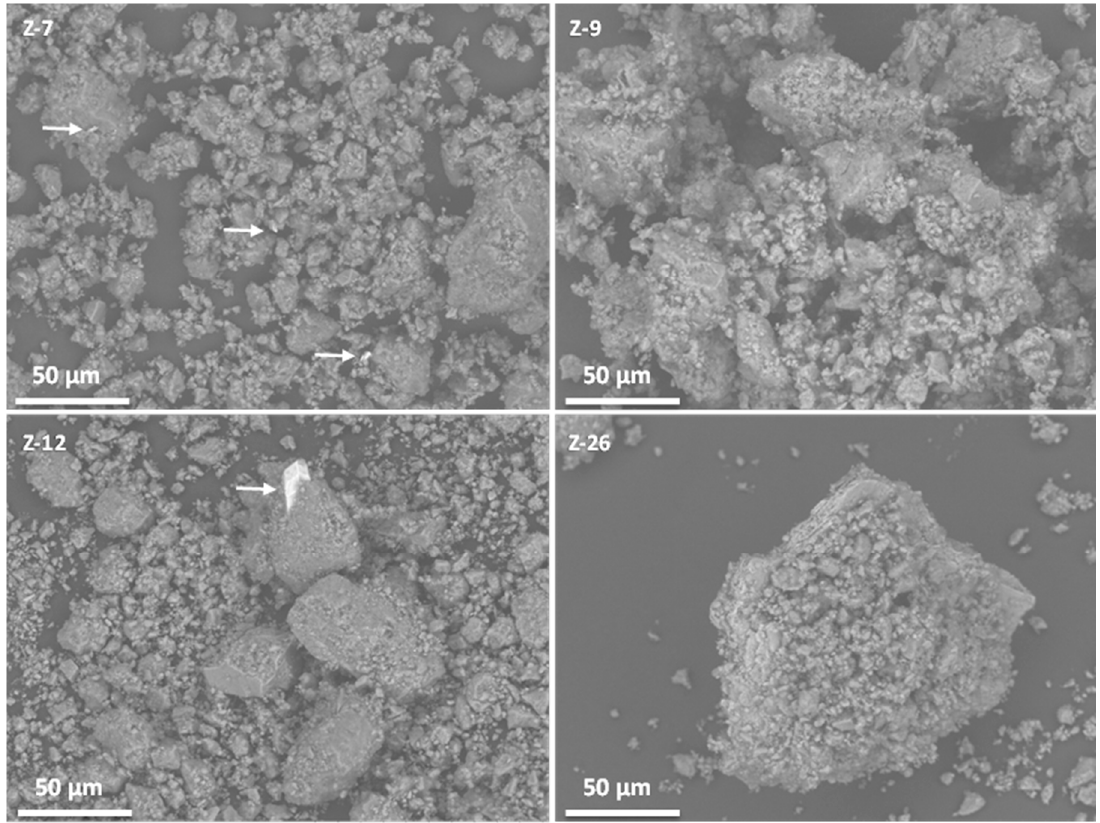
Figure 3. Scanning electron microscopy (SEM) micrographs of natural mordenites. White arrows indicate Fe-based impurities.